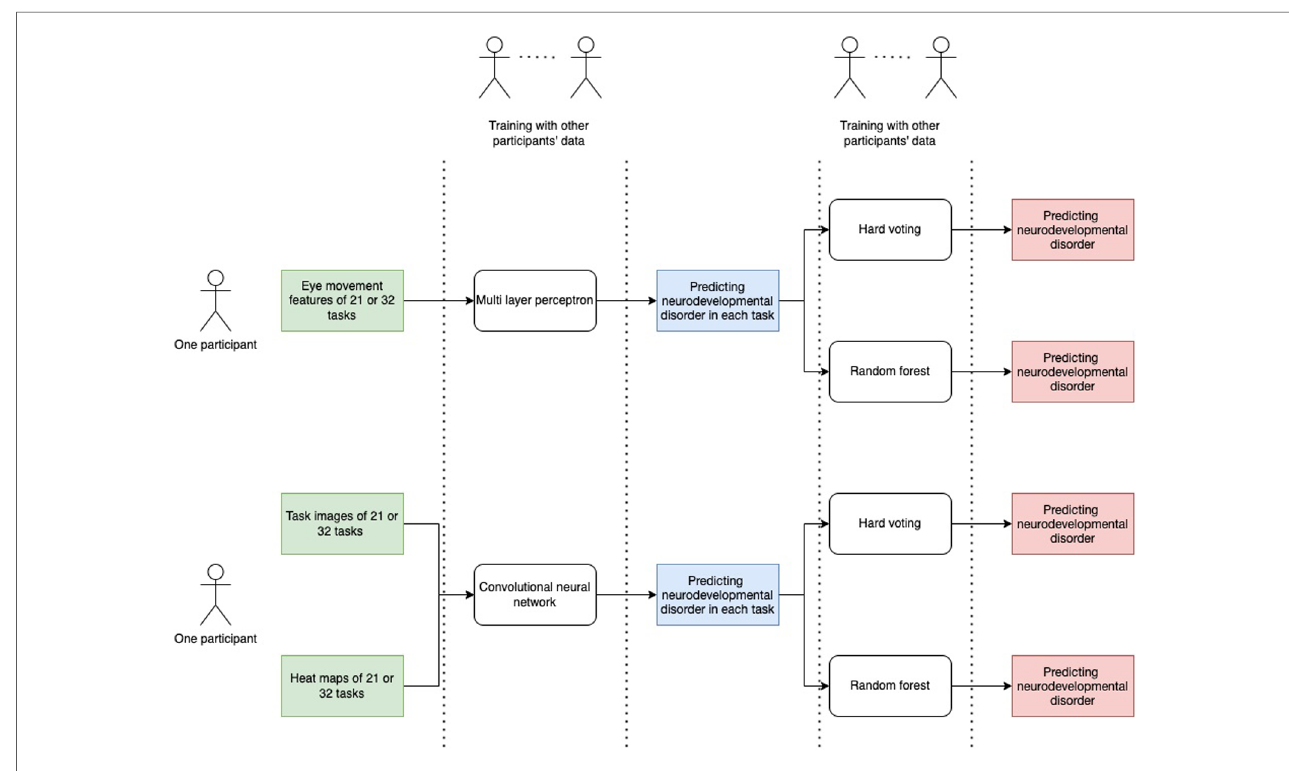
FIGURE 5 Flow of classi fi cation models.